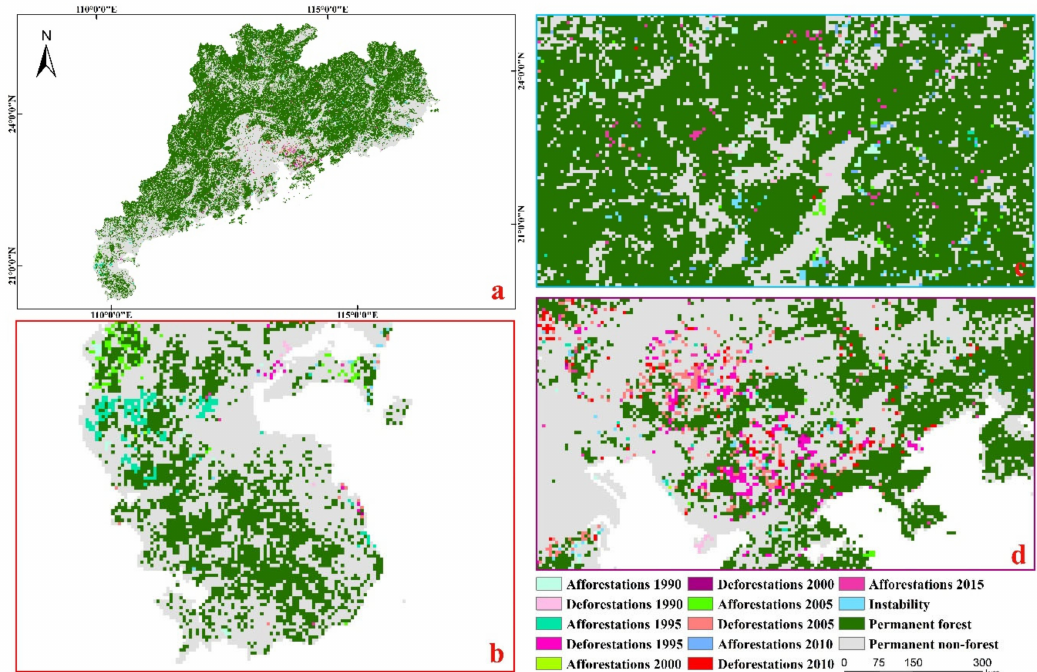
Figure 7. ( a ). Forest change trajectories in the study area during 1980–2015; the changes within the plots are highlighted in ( b ) the Leizhou Peninsula; ( c ) the Wanlu lake; ( d ) the Shenzhen